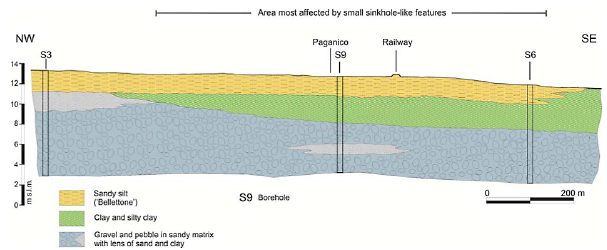
Fig. 3. Lithostratigraphic section of the area most affected by sinkhole-like